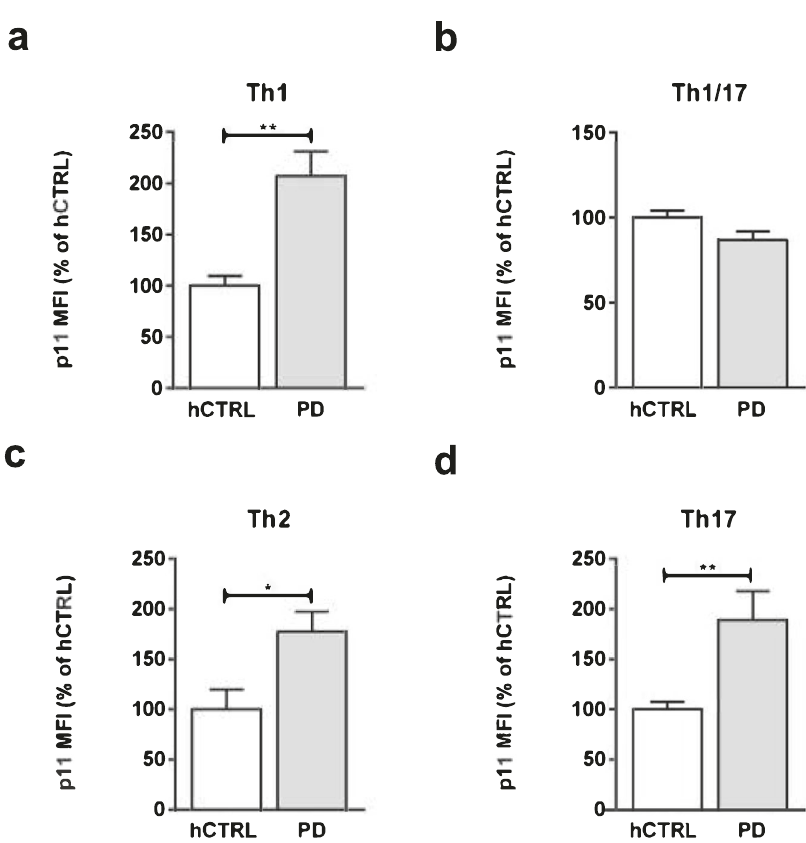
Fig. 6 Speci fi c p11 expression levels in PD-derived CD4 + Th1/Th2/T17 cells. PBMCs derived from 32 PD patients and 16 healthy control subjects were fi xed, permeabilized and stained with monoclonal mouse anti-annexin II light chain (p11) antibody. Subsequently, the cells were stained for the following surface markers: CD3 FITC clone UCHT1, CD4 PE clone OKT4, CXCR3 BV510 clone 1C6, CCR3 APC-Cy7 Clone: 5E8, CCR4 PE-Cy7 Clone: 1G1, CCR6 PerCP Cy5.5 ® clone G034E3, analyzed by FACS and gated towards relevant Th subsets. Quanti fi cation of p11 expression level in a Th1, b Th1/17, c Th2, and d Th17 in PD-derived cells and healthy controls. The data are obtained from six independent experiments. Cumulative median FI data were normalized to the mean of the hCTRL group and expressed as mean ± SEM, within each experiment. Statistical signi fi cance was assessed by using Mann – Whitney test (Th1, Th1/17, and Th17) or Student ’ s t -test (Th2). * p < 0.05, ** p <